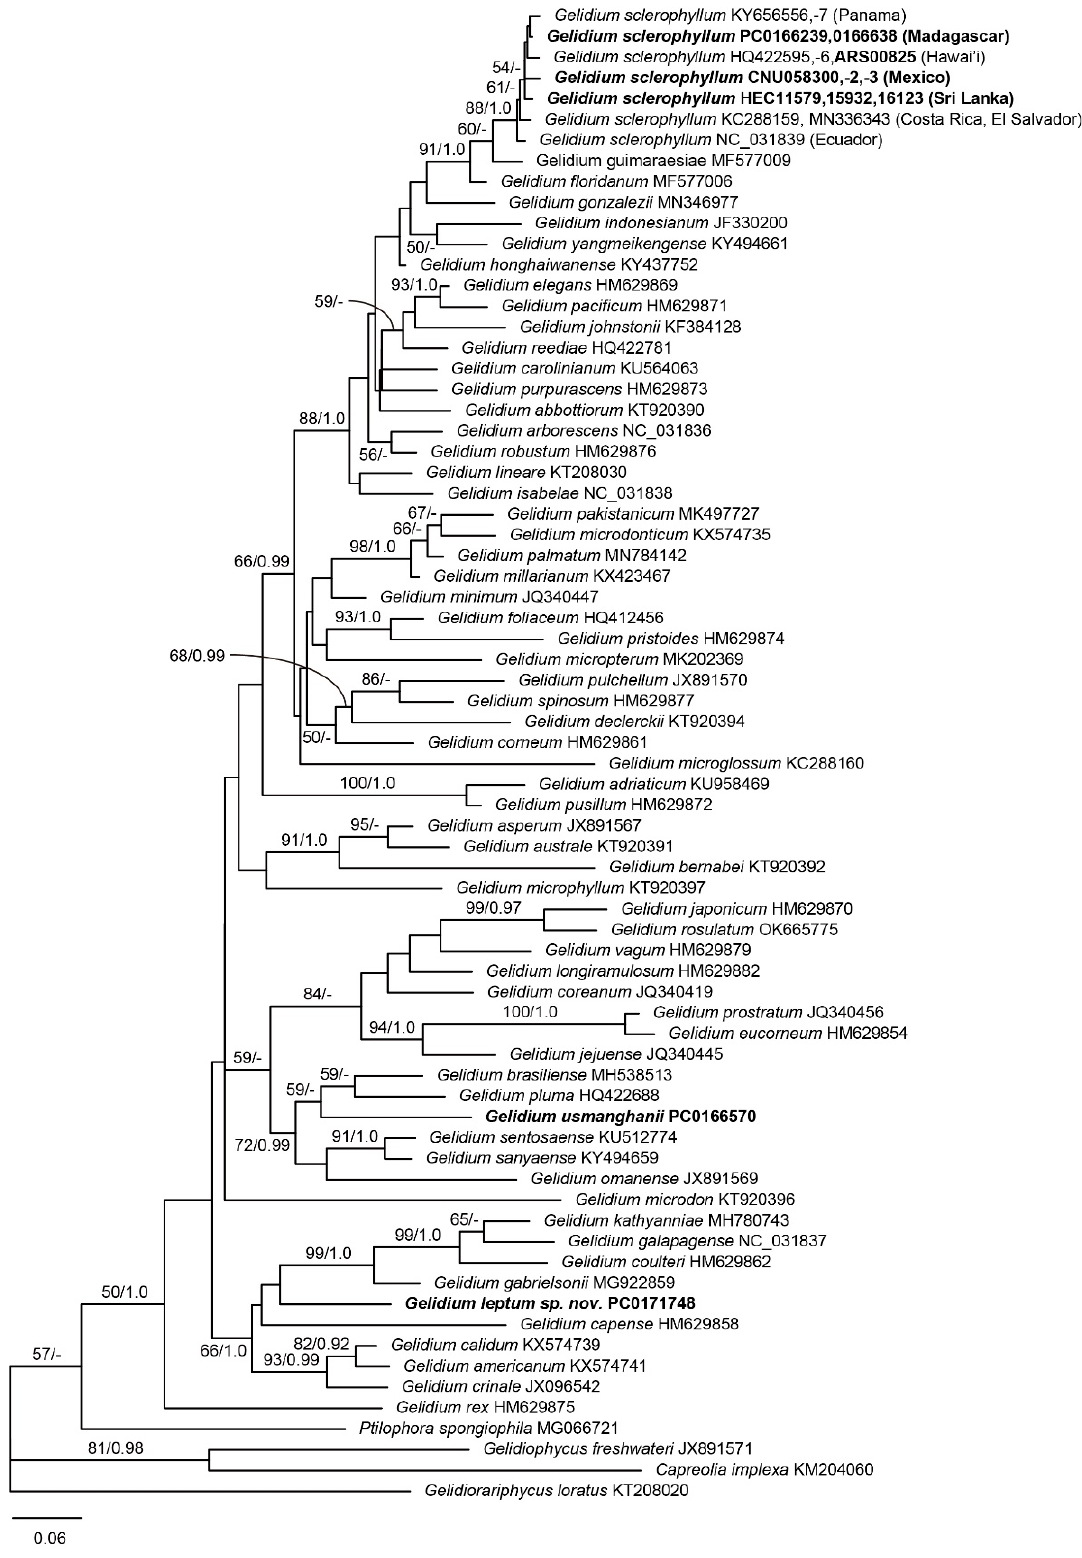
Figure 2. Maximum likelihood (ML) phylogeny of Madagascan Gelidium using mitochondrial cox 1 sequences. ML bootstrap values ( ≥ 50%) and Bayesian posterior probabilities ( ≥ 0.90) are shown at branches. Dash indicates values <50 or <0.90. Bold letter indicates newly generated sequences in the present study.